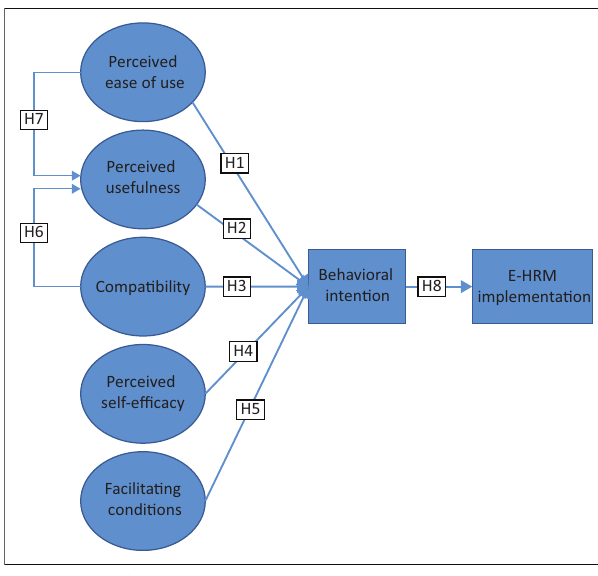
FIGURE 1: Conceptual